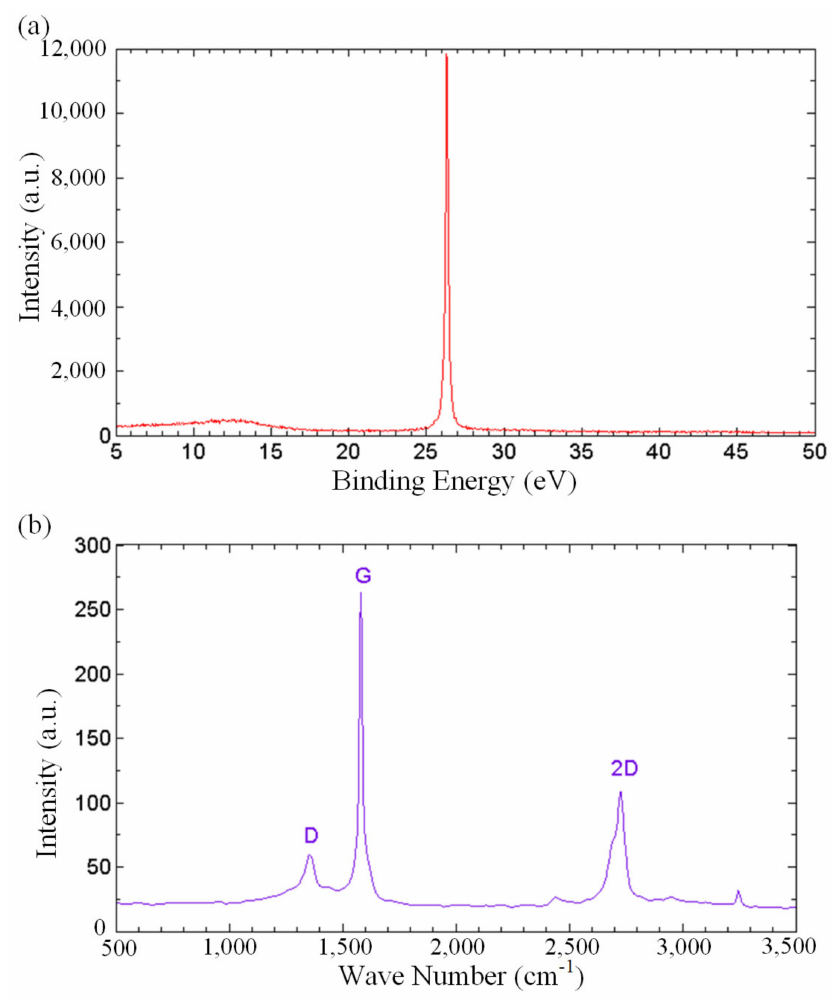
Figure 5. ( a ) XRD spectrum, and ( b ) Raman spectrum of the thermally cured GNPs. To further elucidate the ratio of the non-oxidized regions to the oxidized regions, we conducted X-ray photoelectron spectroscopy (XPS). The XPS wide-scan (survey) spectrum in Figure 6a reveals that the GNPs consist of 87.45% carbon, and 12.55% oxygen based on atomic concentration, with a carbon to oxygen ratio of 6.96. The XPS narrow scan conducted on carbon bonds (C1s) revealed the population of oxygenated functional groups attached on the graphene nanostructures. As depicted in Figure 6b, the primary spectrum mani- fests a peak of graphitic C–C bond at 284.83 eV. The functional epoxy (C–O–C), carboxyl (O=C–OH) and hydroxyl (C–OH) groups are identified in the spectra by the peaks of 289.98 eV, 286.74 eV and 285.92 eV, respectively. The population of the hydrophilic